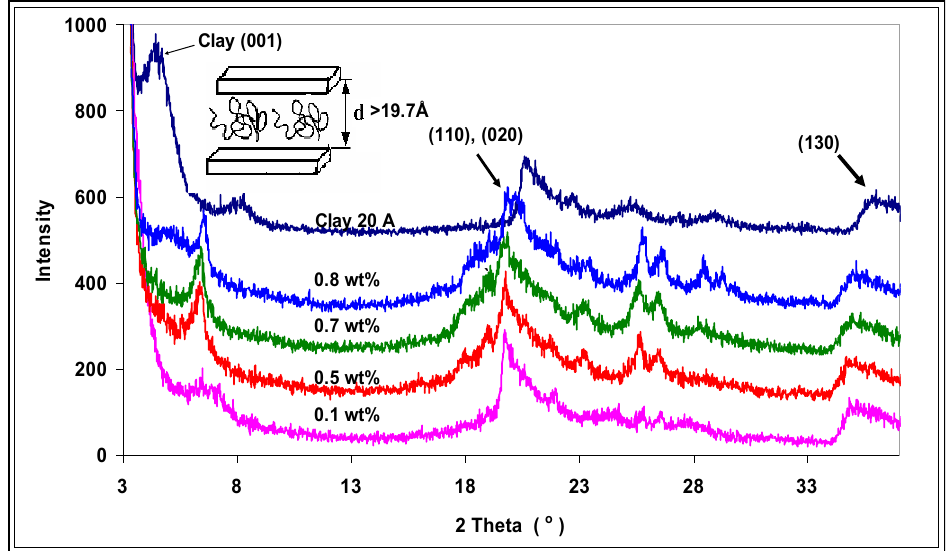
Figure 9. WAXD pattern of Cloisite 20A clay and PACN as a function of APS concentration, showing the disappearance of d 001 peak due to high level of intercalation and partial exfoliation of clay.